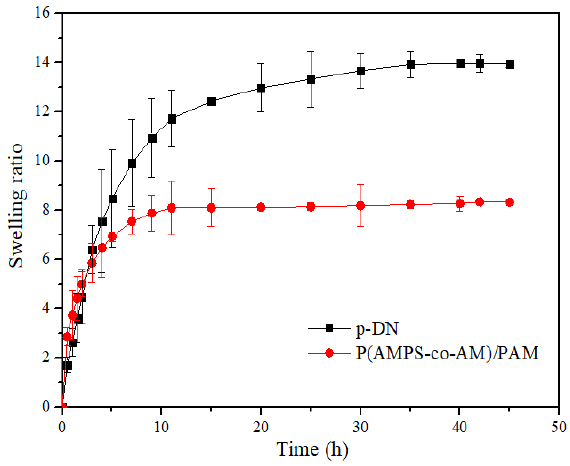
Figure 4. Swelling ratio of P(AMPS–co–AM)/PAM DN and p–DN hydrogels.